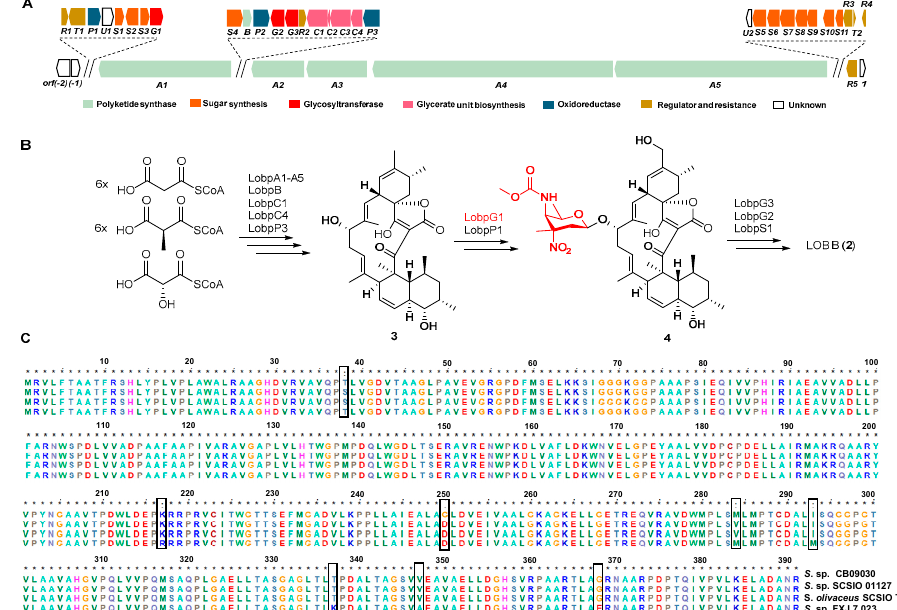
Figure 4. Bioinformatic analysis of LOB BGC in S . sp. CB09030. ( A ) Genetic organization of